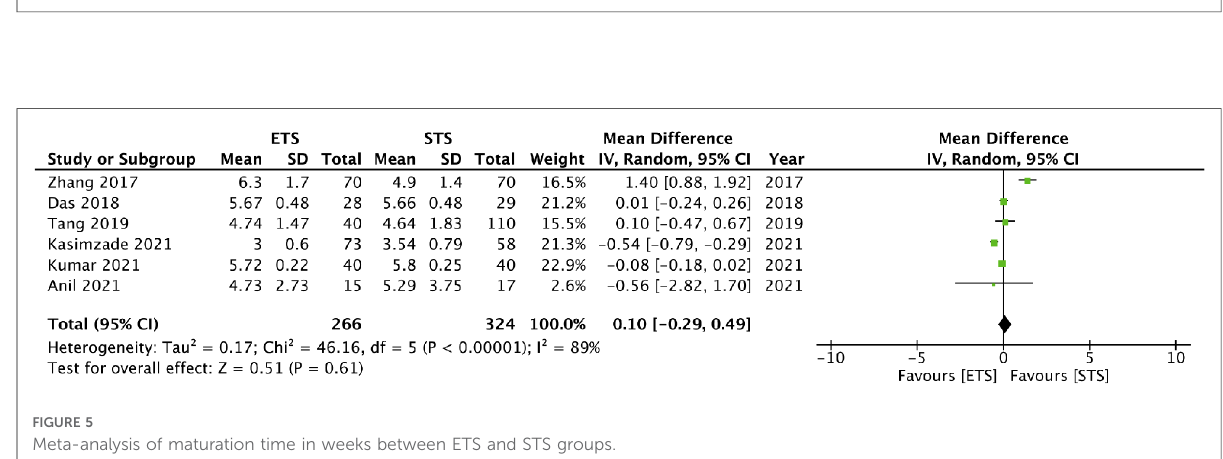
FIGURE 4 Meta-analysis of patency rates at 12 months between ETS and STS groups with subgroup analysis based on type of study.